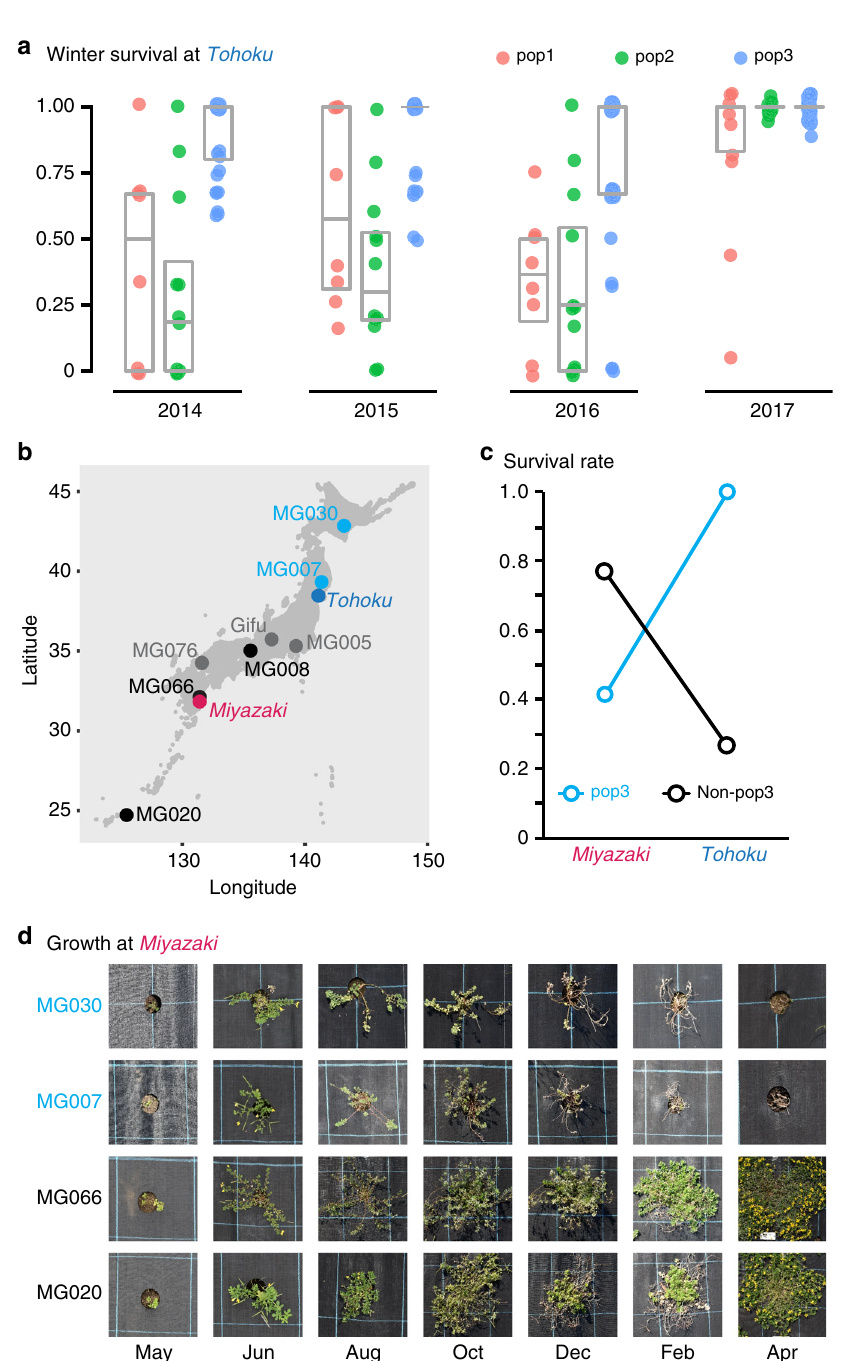
Fig. 4 Pop3 local adaptation. a Winter survival boxplot based on data from 610 individuals from 57 non-admixed accessions. The plots show data for the planting year indicated with each dot representing an accession mean. The horizontal gray bar indicates the median, and the lower and upper hinges correspond to the 25th and 75th percentiles. b The geographical origin of pop3 (blue), non-pop3 (black) and admixed (gray) accessions grown at fi eld sites in both Miyazaki (red italics) and Tohoku (blue italics) is indicated. c Average survival rates of pop3 and non-pop3 accessions at the fi eld sites in Miyazaki and Tohoku based on data from fi ve accessions grown at both sites (MG020, MG066, MG008, MG007, and MG030). d Pictures from the fi eld site at Miyazaki, 31.83°N, 131.41°E. Accessions IDs are indicated to the left and months in 2017/2018 below the pictures. Source data underlying a , c are provided as a Source Data fi